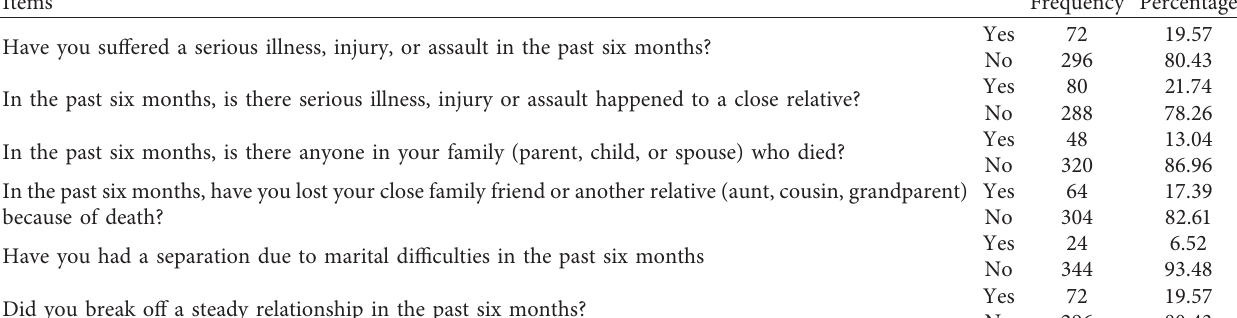
Items Frequency